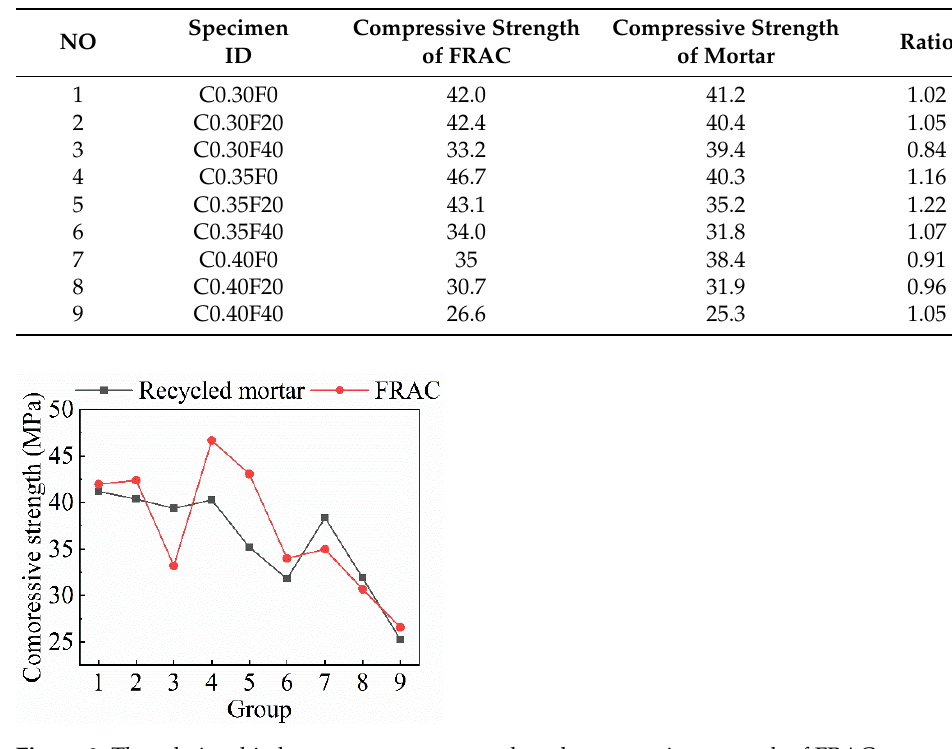
Figure 9. The relationship between mortar strength and compressive strength of FRAC.